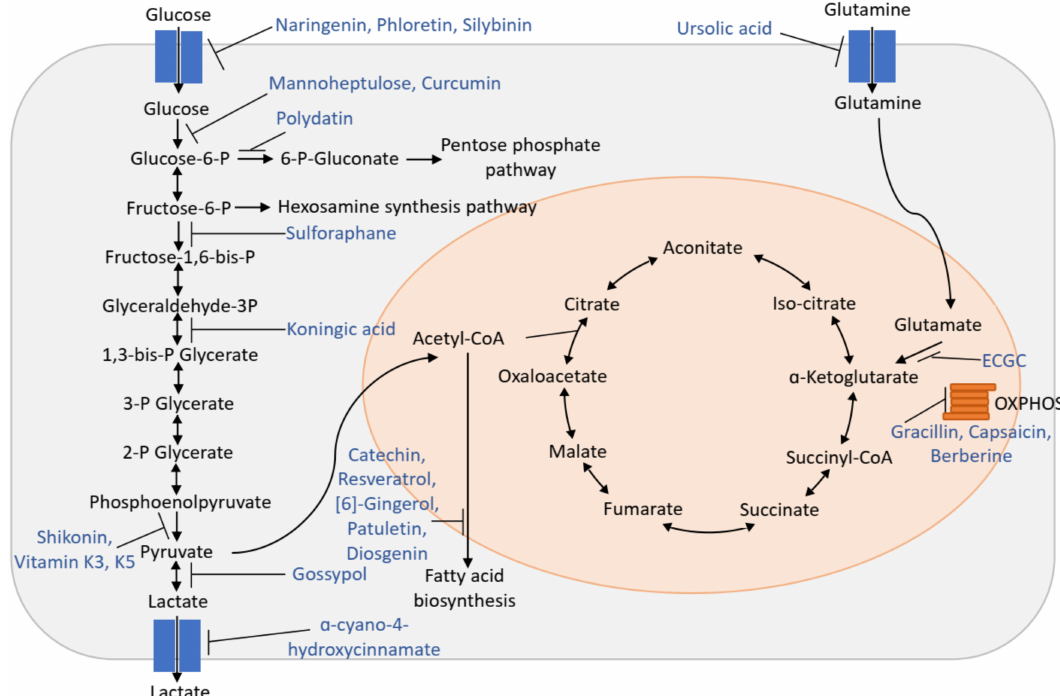
Figure 1. Di ff erent bioactive compounds that target metabolic processes. The primary target step of